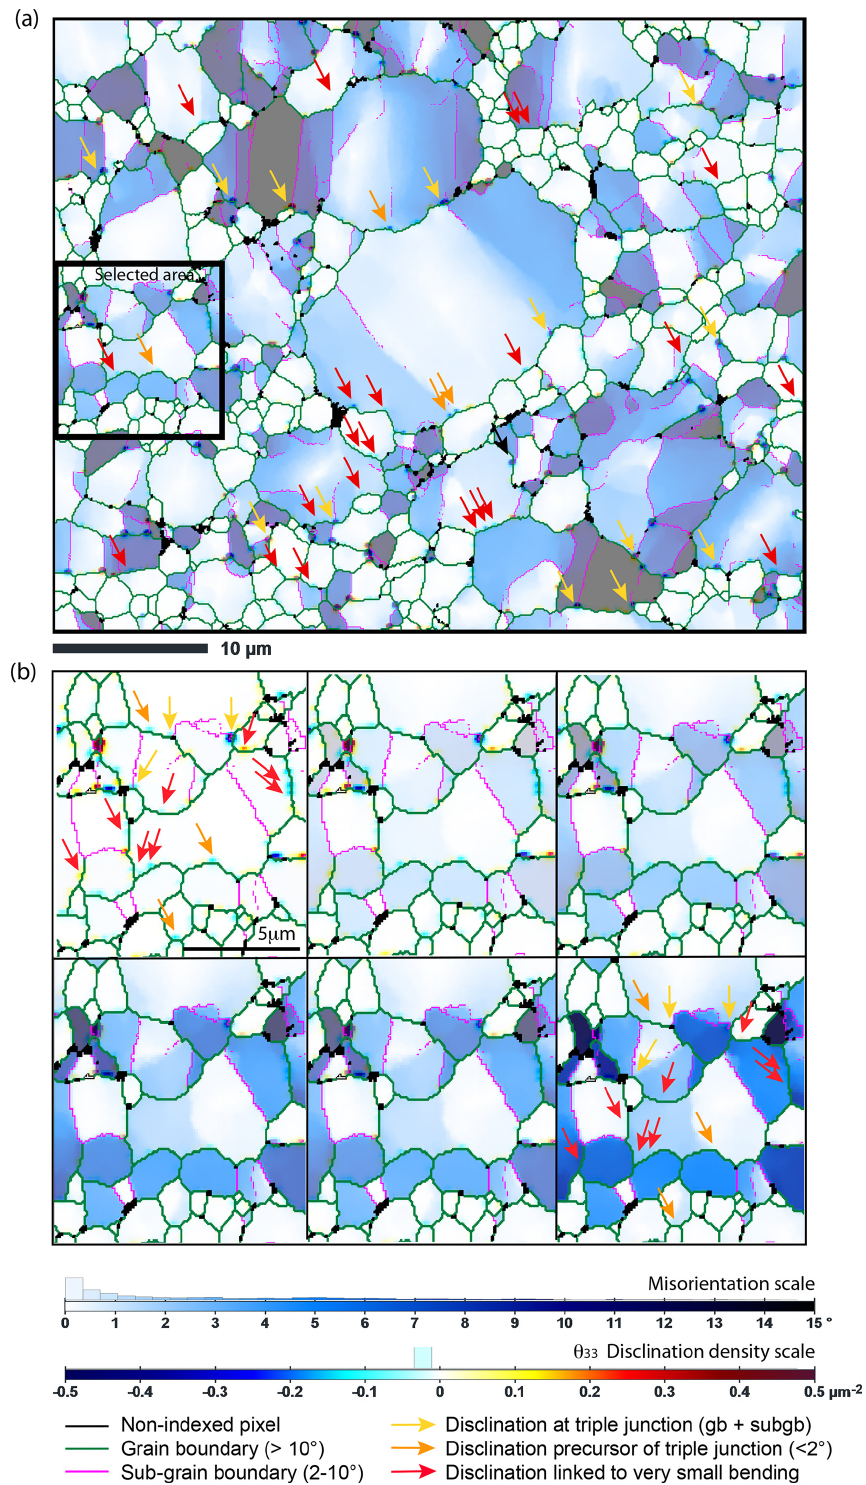
Figure 14. (a) Misorientation maps in sample CMT-16-9 (extracted in the full map) overlaid on the disclination density map ( θ 33 only). Misorientation in each grain is relative to the center of gravity. (b) Further enlargement of the map in (a) but for different levels of overlay to show the relationship between misorientation from GND and misorientation from disclinations. Three types of disclinations are identified (yellow, orange, and red arrows). See main text for details and Fig.